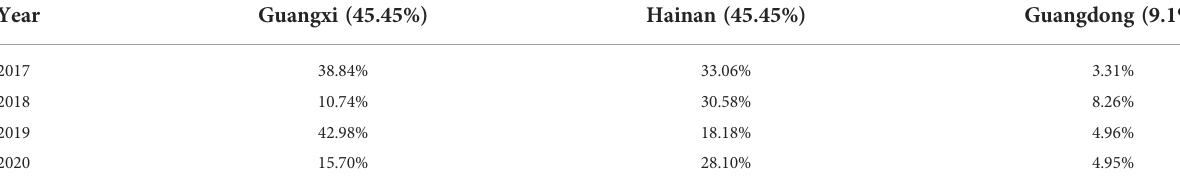
TABLE 1 The proportion of fi shing vessels in different provinces during the fi shing